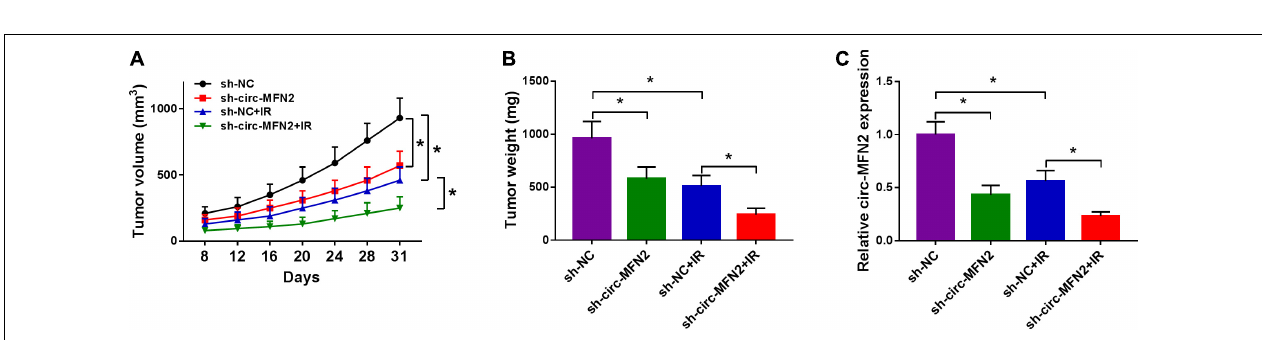
FIGURE 2 | Circ-MFN2 knockdown inhibited CRC progression. SW620 and SW480 cells were transfected with si-NC or si-circ-MFN2, and non-transfected cells were used as control. (A) The expression of circ-MFN2 was detected by qRT-PCR to evaluate transfection efficiency. (B,C) MTT assay was used to measure the viability of cells. (D) The number of colonies was determined using colony formation assay. (E,F) Transwell assay was used to assess the migration and invasion of cells. (G,H) The survival fraction of cells was examined using colony formation assay. * P < 0.05.